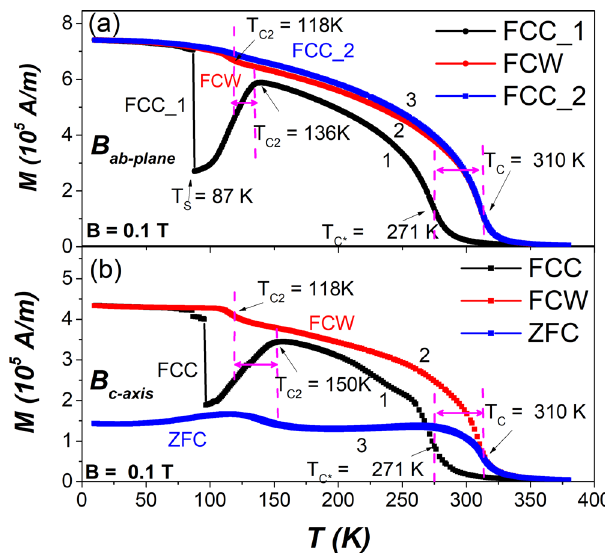
Fig. 3 Magnetization vs. temperature of Fe 5 GeTe 2 . The external fi eld B is applied along the c-axis and in the ab-plane with a fi eld strength of 0.1 T, while the temperature T is varied and the magnetization M is measured. Zero fi eld cooled (ZFC) indicates that the sample was cooled without application of an external fi eld and then the fi eld of 0.1 T was applied at the lowest temperature followed by measurements performed during